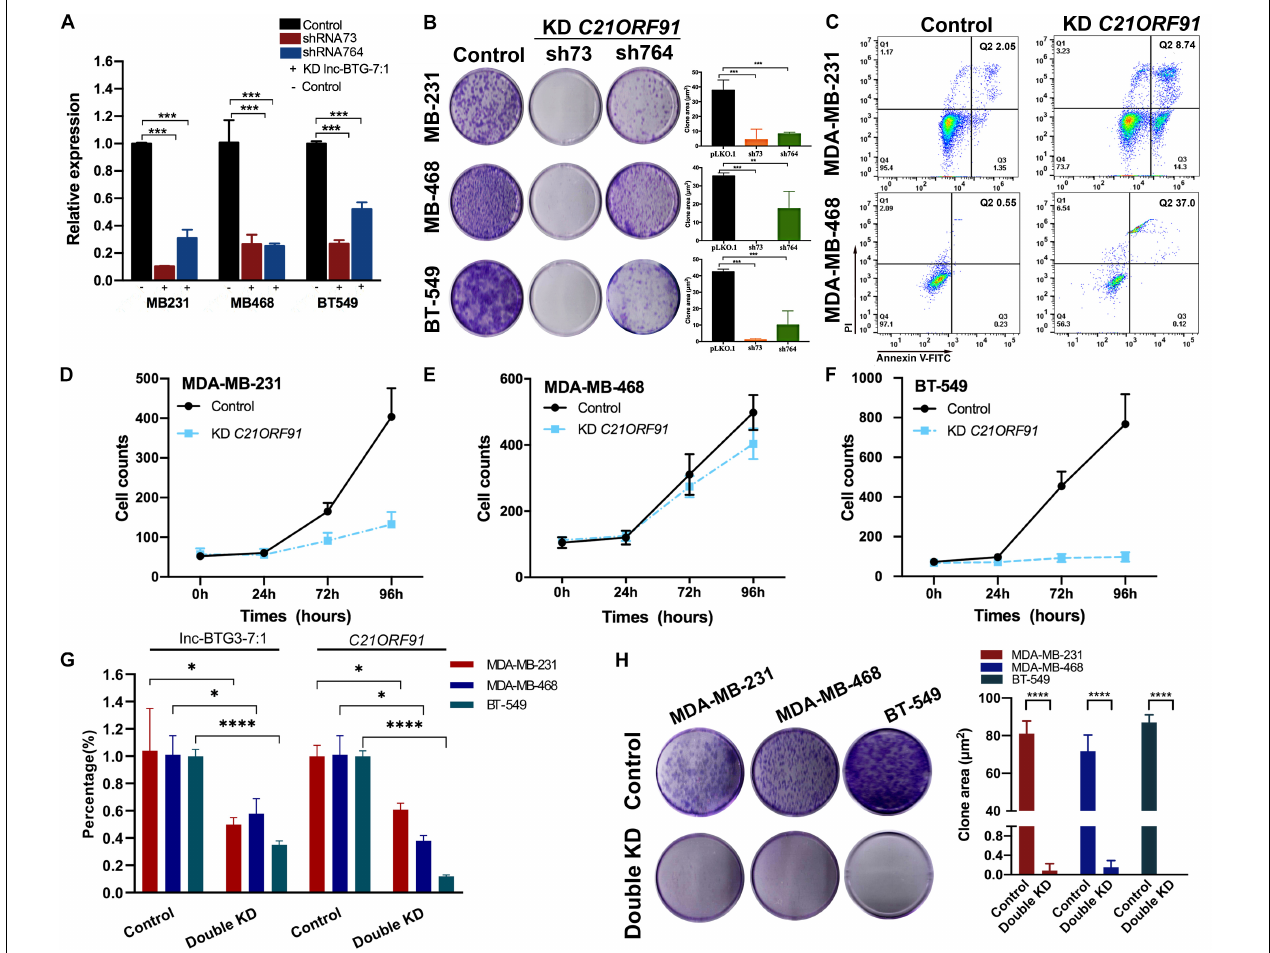
FIGURE 4 | Lnc-BTG3-7:1 and target C21ORF9 1 gene participates in the process of TNBC progress. (A) The expression levels of C21ORF91 in three TNBC cell lines significantly decreased after C21ORF91 gene knockdown (* P < 0.05, ** P < 0.01, *** P < 0.005). (B) Knockdown of C21ORF91 significantly reduced colony forming capacity of the three TNBC cell lines ( P < 0.05). (C) Knockdown of C21ORF91 (with shRNA73) induced early apoptosis (Q3: 14.3%) cells and late apoptosis (Q2: 8.74%) cells compared to that of the control group (Q3: 1.35%, Q2: 2.05%) in MDA-MB-468; and early apoptosis (Q3: 0.12%) cells and late apoptosis (Q2: 37.0%) cells compared with the control group (Q3: 0.23%, Q2: 0.55%) in MDA-MB-231 ( P < 0.05), respectively. (D–F) Short-term proliferation capacity of TNBC cell lines were inhibited after knocking down of C21ORF91 , especially in MDA-MB-231 and BT-549 ( P < 0.05). (G) The expression levels of C21ORF91 in three TNBC cell lines significantly decreased after double knockdown of Lnc-BTG3-7:1 and C21ORF91 gene (* P < 0.05, ** P < 0.01, *** P < 0.005). (H) Double knockdown of Inc-BTG3-7:1 and C21ORF91 gene inhibited long-term proliferation capacity of three TNBC cells ( P <